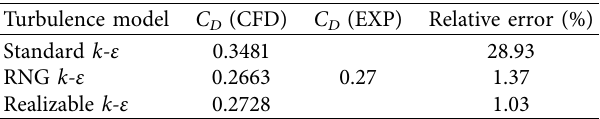
Table 2: Comparison of drag coefficients simulated by three turbulence models with experimental values. Turbulence